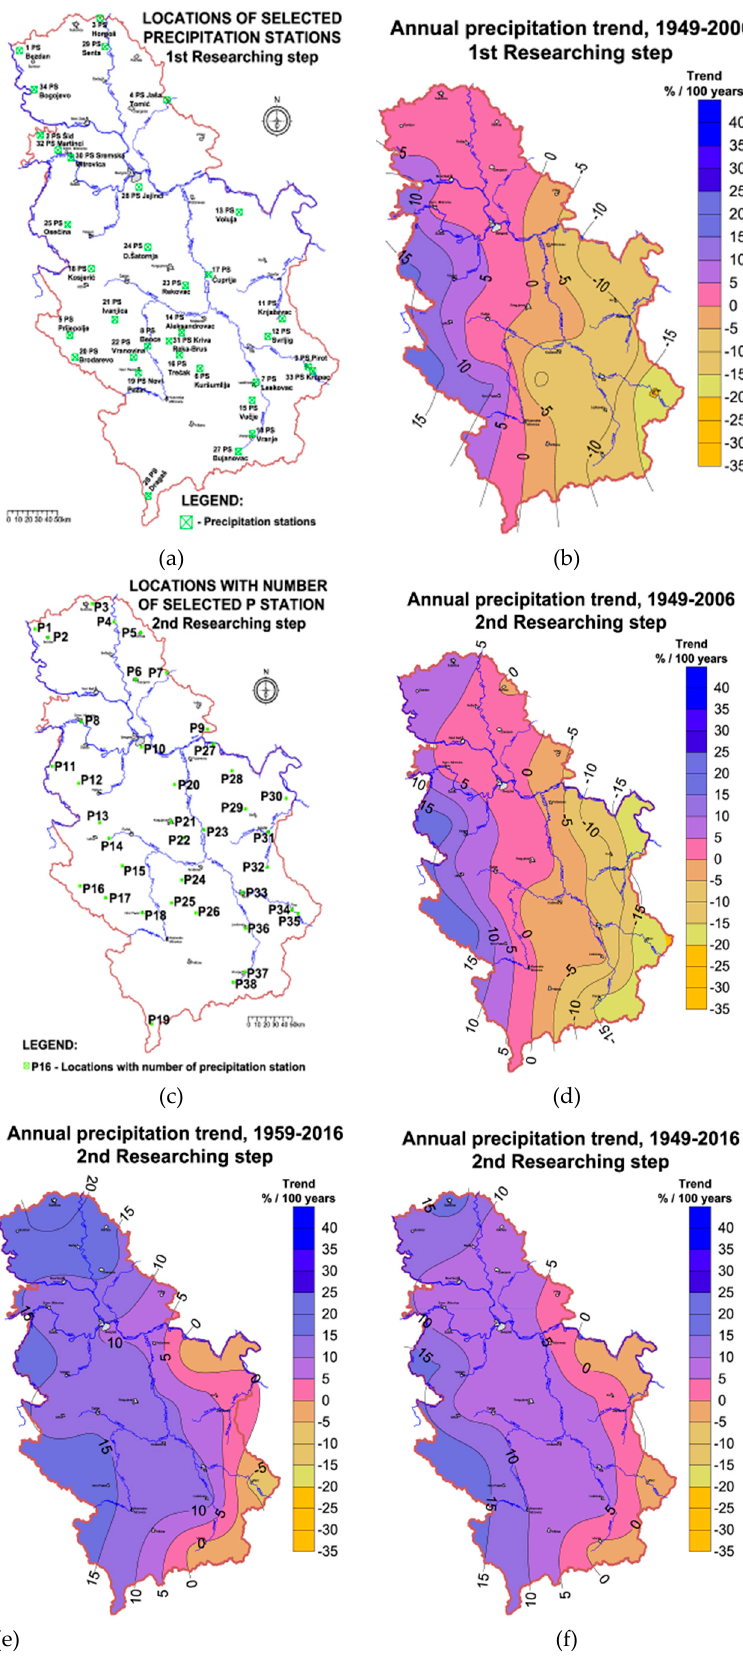
Figure 2. Figure 2a presents the locations of selected P stations and Figure 2b presents the spatial P trend distribution for period 1949–2006 in the 1st researching step. Figure 2c-f present the same (the locations and the spatial P trend distribution for three periods) in the 2nd researching